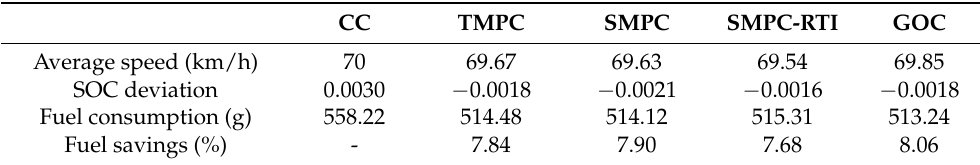
Table 5. Performance of the EC using different speed controllers.